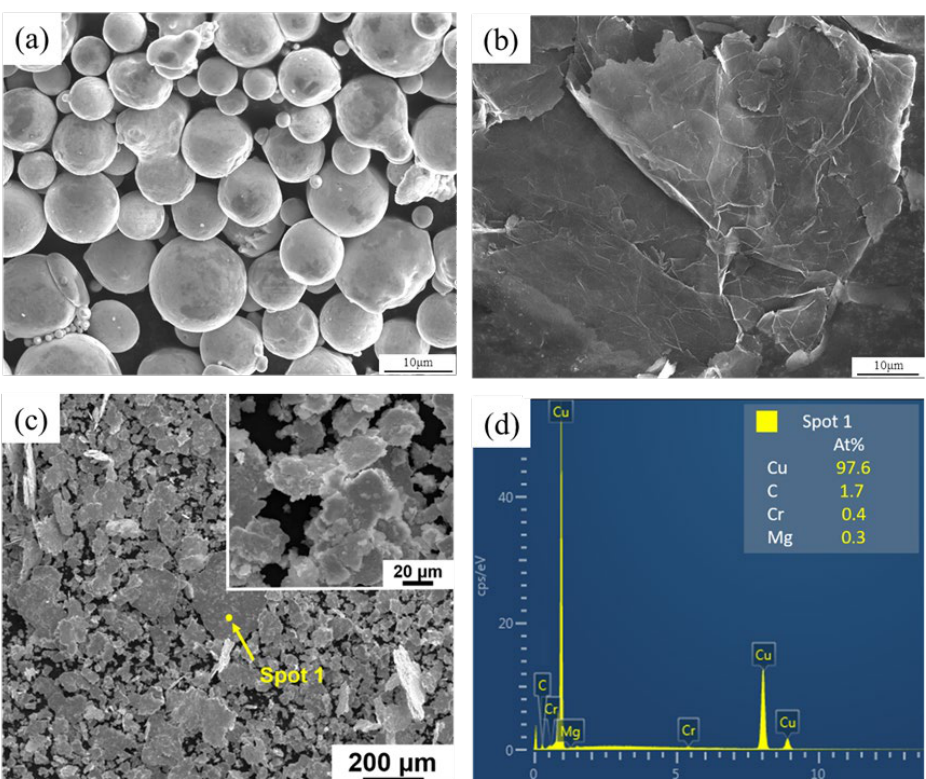
Figure 2. SEM images of GNPs/Cu–Cr–Mg composite powders; ( a ) gas atomized Cu–Cr–Mg alloy powder, ( b ) raw GNPs, ( c ) GNPs/Cu–Cr–Mg mixture powder, and ( d ) EDS results of spot 1.